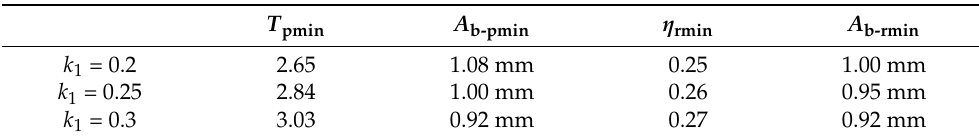
Table 5. The lowest peak transmissibility/resonant frequency and the corresponding excitation amplitudes with different values of k 1 . T pmin